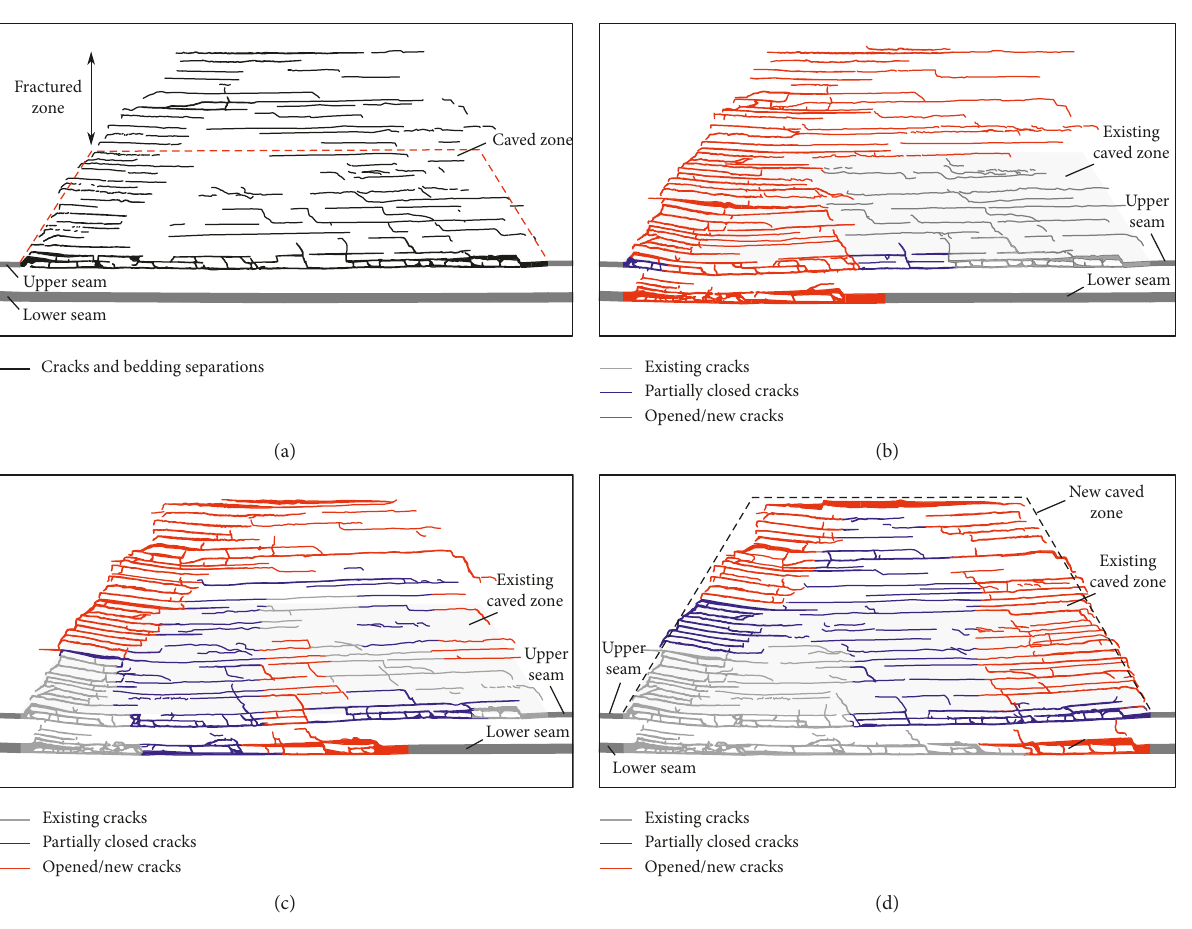
Figure 9: Crack propagation after extraction of (a) lower panel and (b–d) different segments of the upper panel in Case